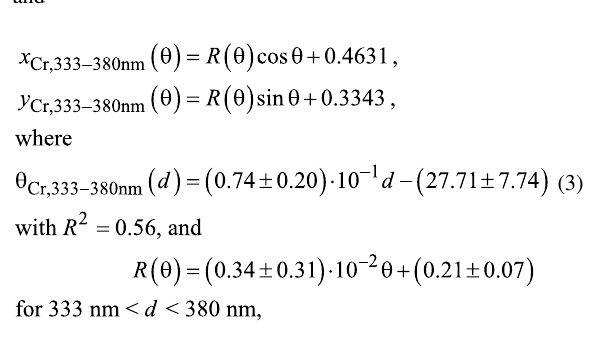
Figure 3: (a) Representation of CIE 1931 colour diagram for different metals (Cr and Au) and different Au thicknesses (10, 17.5 and 25 nm). (b) The values of x and (c) the values of y as a function of metal thickness. The range of AAO thickness is 209–380 nm for all nanostructures plotted in the figure.